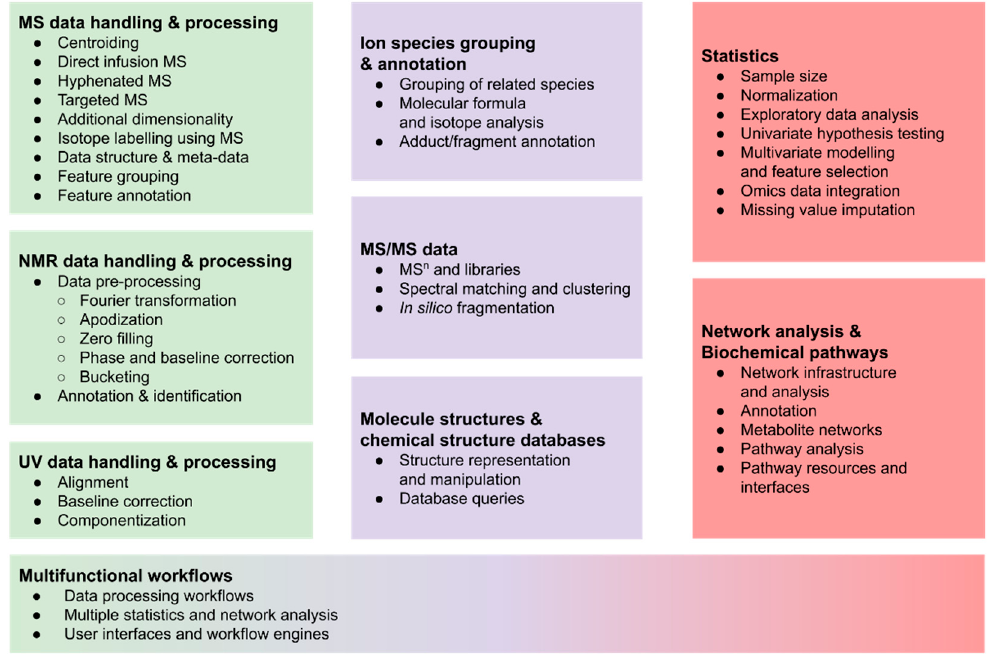
Figure 1. Overview of typical tasks in metabolomics workflows, ranging from metabolite profiling ( left , green) via metabolite annotation ( center , purple) to data analysis using statistics and metabolite networks ( right , red).